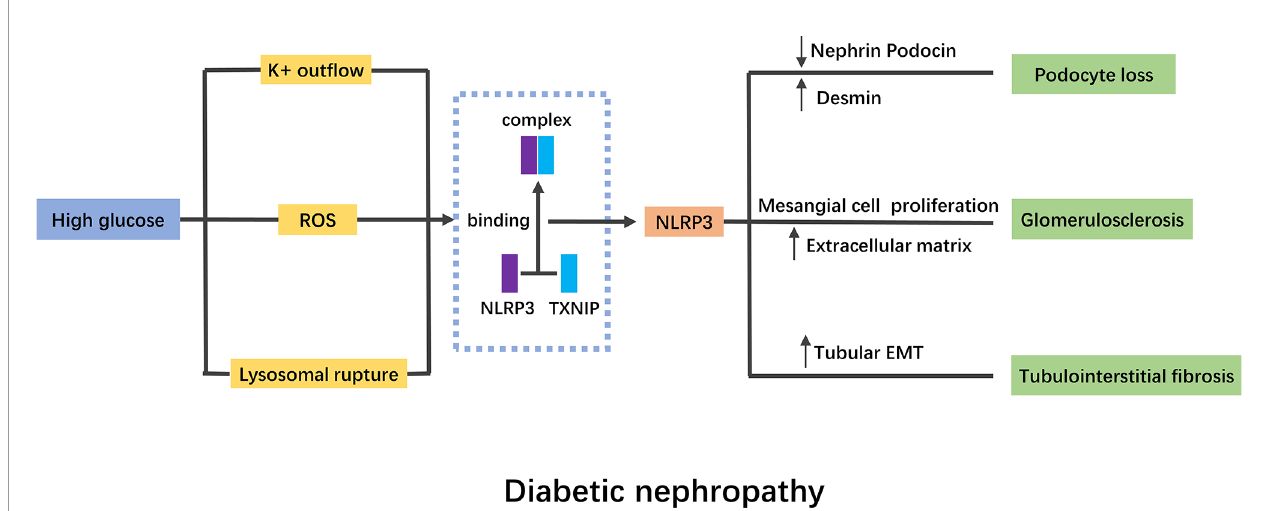
FIGURE 2 | Mechanism of NLRP3 in fl ammasome in diabetic nephropathy. High glucose stimulation activates NLRP3 in fl ammasome mainly through K+ out fl ow, ROS and lysosomal rupture. TNXIP binding to NLRP3 is a pivotal mechanism of NLRP3 in fl ammasome activation. The activation of NLRP3 in fl ammasome will lead to podocyte lose, glomerulosclerosis and tubulointerstitial fi brosis. NLRP3, nod like receptor protein 3; ROS, reactive oxygen species; EMT, epithelial mesenchymal